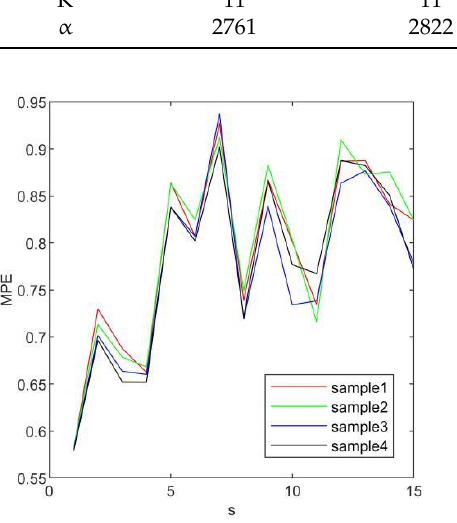
Figure 7. MPE of the first intrinsic mode function of different samples.